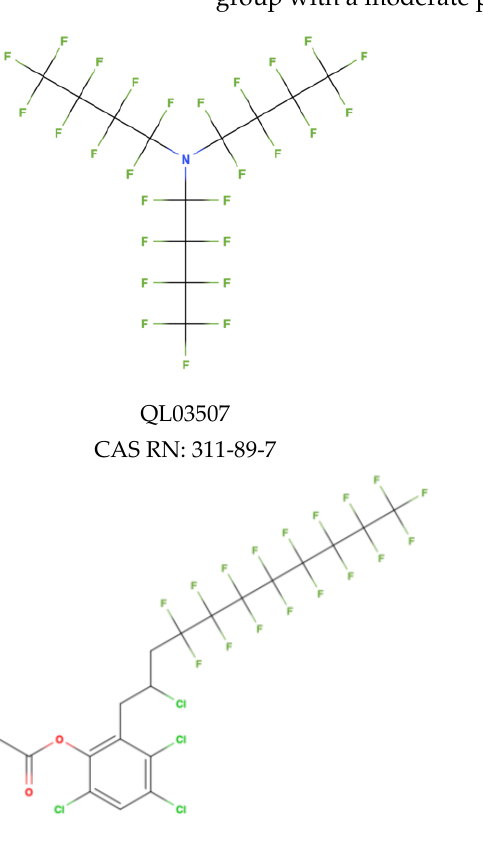
Figure 5. Scatter plot of binding scores obtained for PPARβ in X% and ICR space ( A ); Scatter plot for PPAR β showing the division of PFAS into 5 different structural groups in space of X% and ICR. C-carboxylic acids (COOH-(CF2)n-CF3), S-sulfonic acids (SO3H-(CF2)n-CF3), P-phosphonic acids (PO3H2-(CF2)n-CF3, F-Fluorotelomer alcohol (F1-F7(OH-(CH2)-(CF2)n-CF3), F8-F14 (OH-(CH2)2- (CF2)n-CF3), F16 (OH-(CH2)3-(CF2)n-CF3), F17 (OH-(CH2)4-(CF2)n-CF3)), Y-dicarboxylic acids (COOH-(CF2)n-COOH). Colors: green-low binding probability, yellow-moderate binding probability ( B ); table showing binding score values for each compound shown in chart B ( C ).